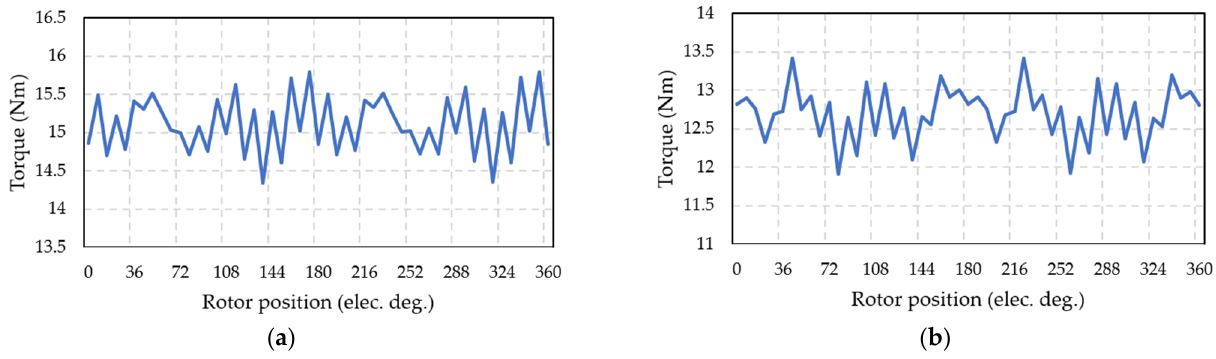
Figure 14. Torque waveforms of two motors: ( a ) 39 − slot and 6 − pole motor of UBW; ( b ) single − layer 39 − slot and 6 − pole